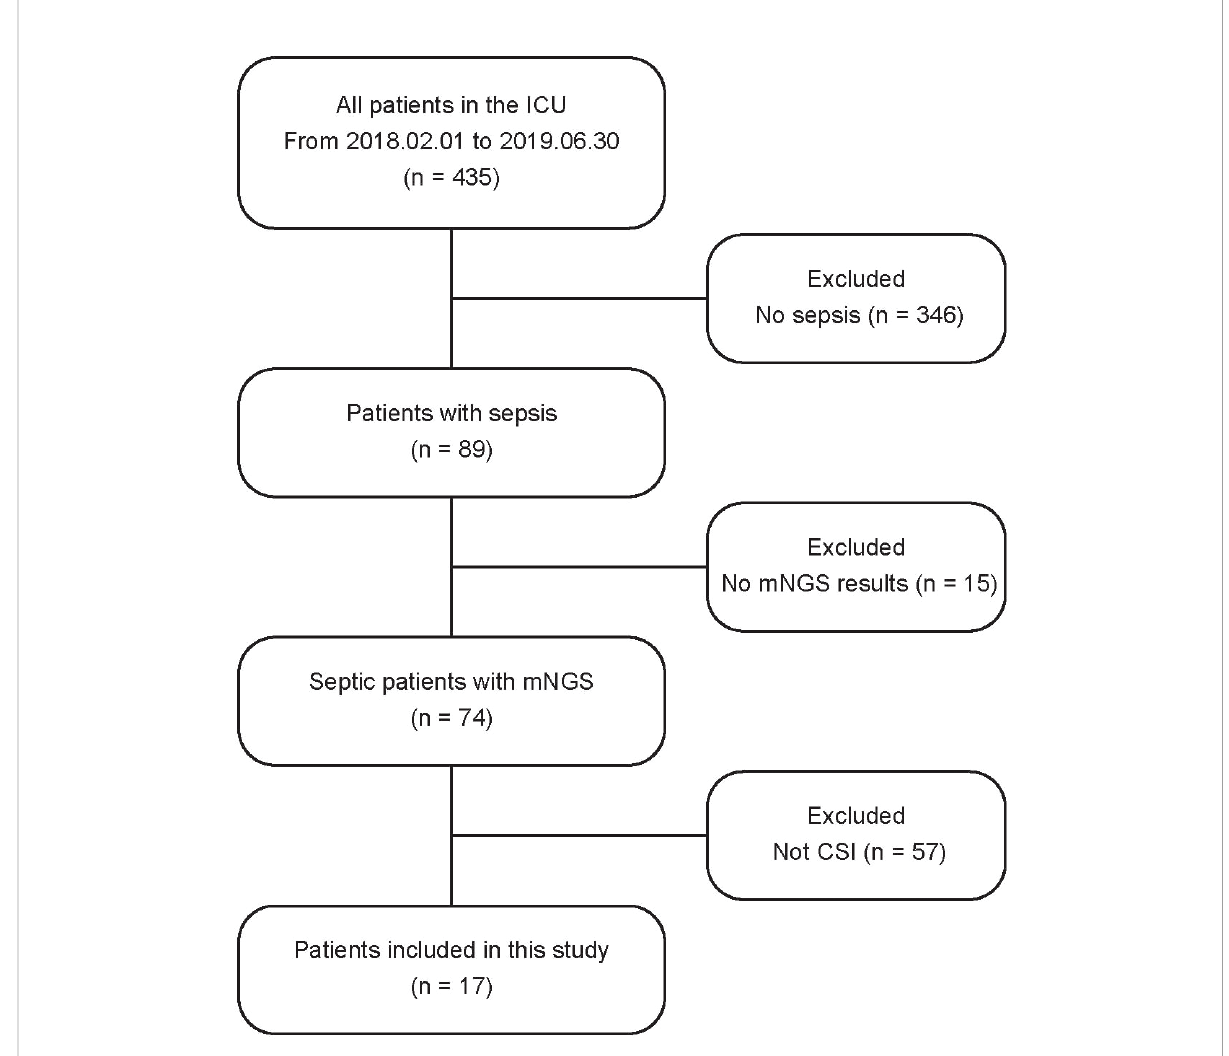
FIGURE 1 Flowchart diagram. The recruiting process of patients in the study.